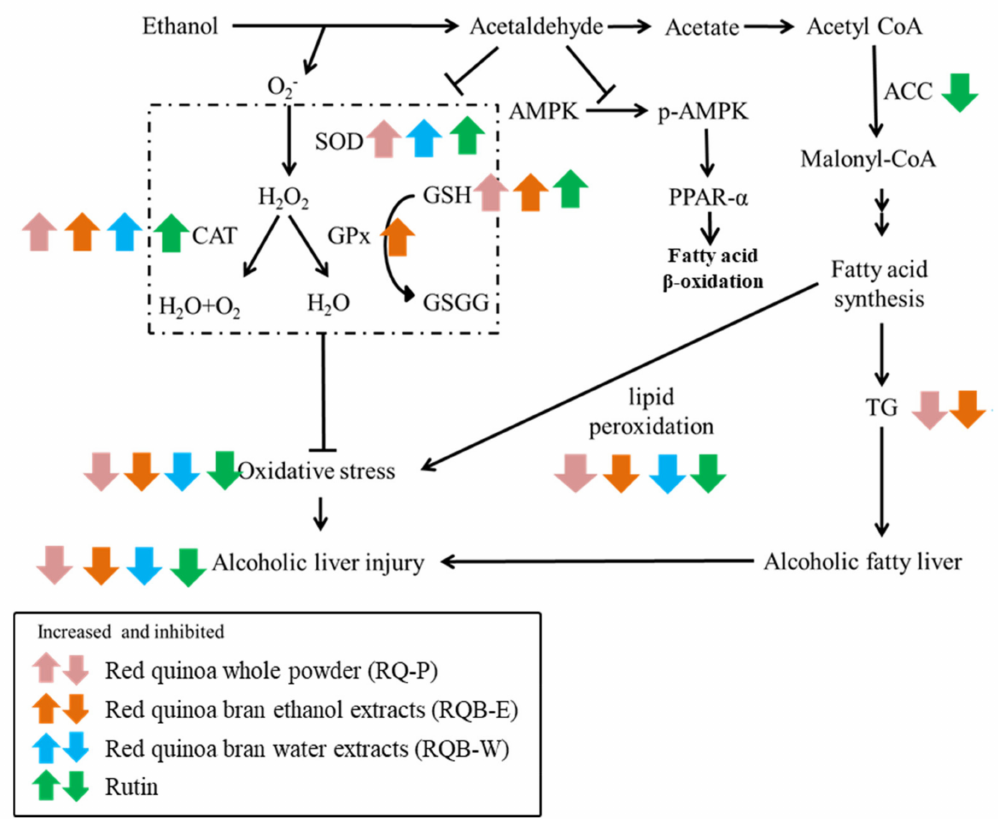
Figure 5. The regulation on the relative factors expression in liver of AFLD mice. The arrow indicates the increased or decreased regulation with significant effect ( p < 0.05, as compared to EtOH